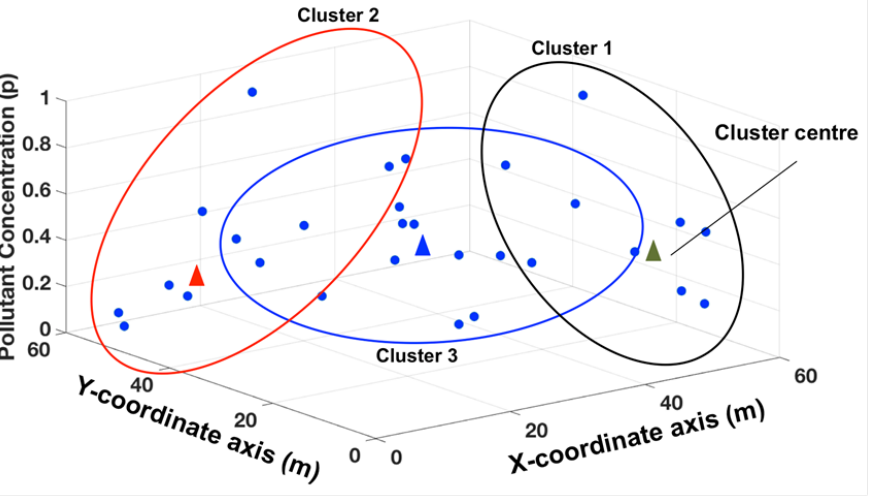
Figure 2. Theoretical visualization of fuzzy clustering in the three-dimensional product space. After clustering, each data point has membership to one or more cluster centers, depending on the pollutant concentration. The clusters are then partitioned onto the x and y Cartesian product space and a membership function is generated for the x and y coordinate axis of each cluster. The membership functions from each cluster are then used to determine the degree of membership an un-sampled location has to the different clusters within the data (see Figure 3).